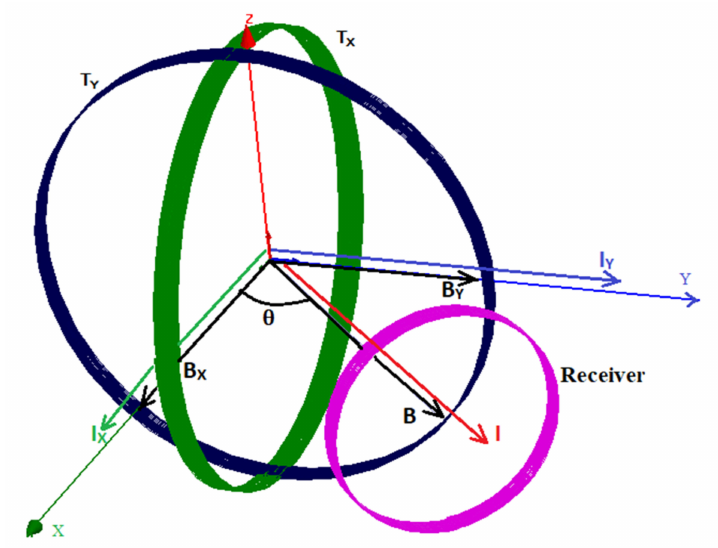
Figure 1. Two-dimensional (2D) WPT system magnetic and electric resultant vector. We define the currents flowing in each transmitting coil as i x i y , producing a magnetic field B x B y , respectively. The resultant current vector I , and the resultant magnetic field vector B of the two transmitting-end coils are related as derived in